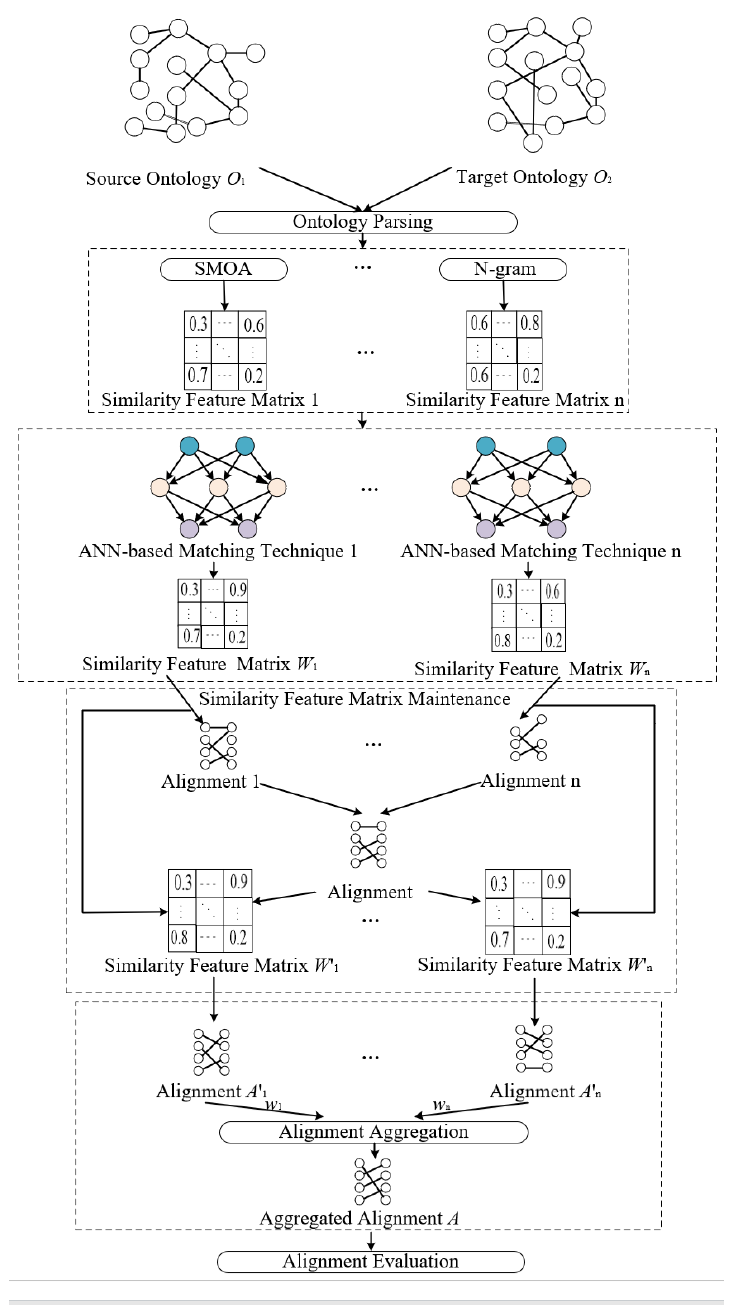
Figure 1. The Framework of Aggregating ANN-based Ontology Matching Techniques.